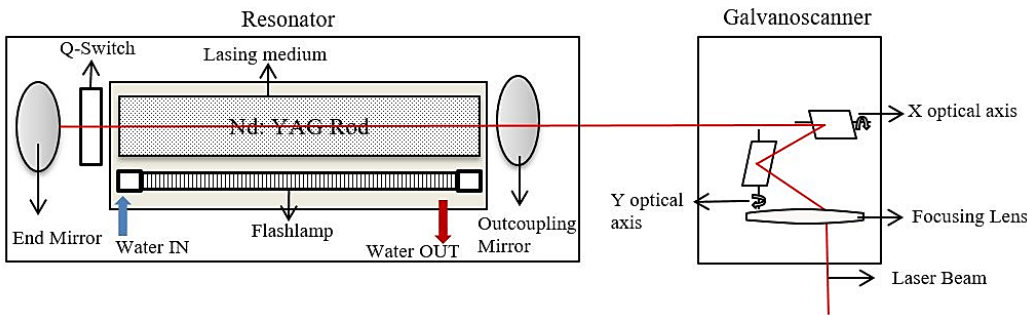
Figure 1. Schematic diagram of the laser setup .